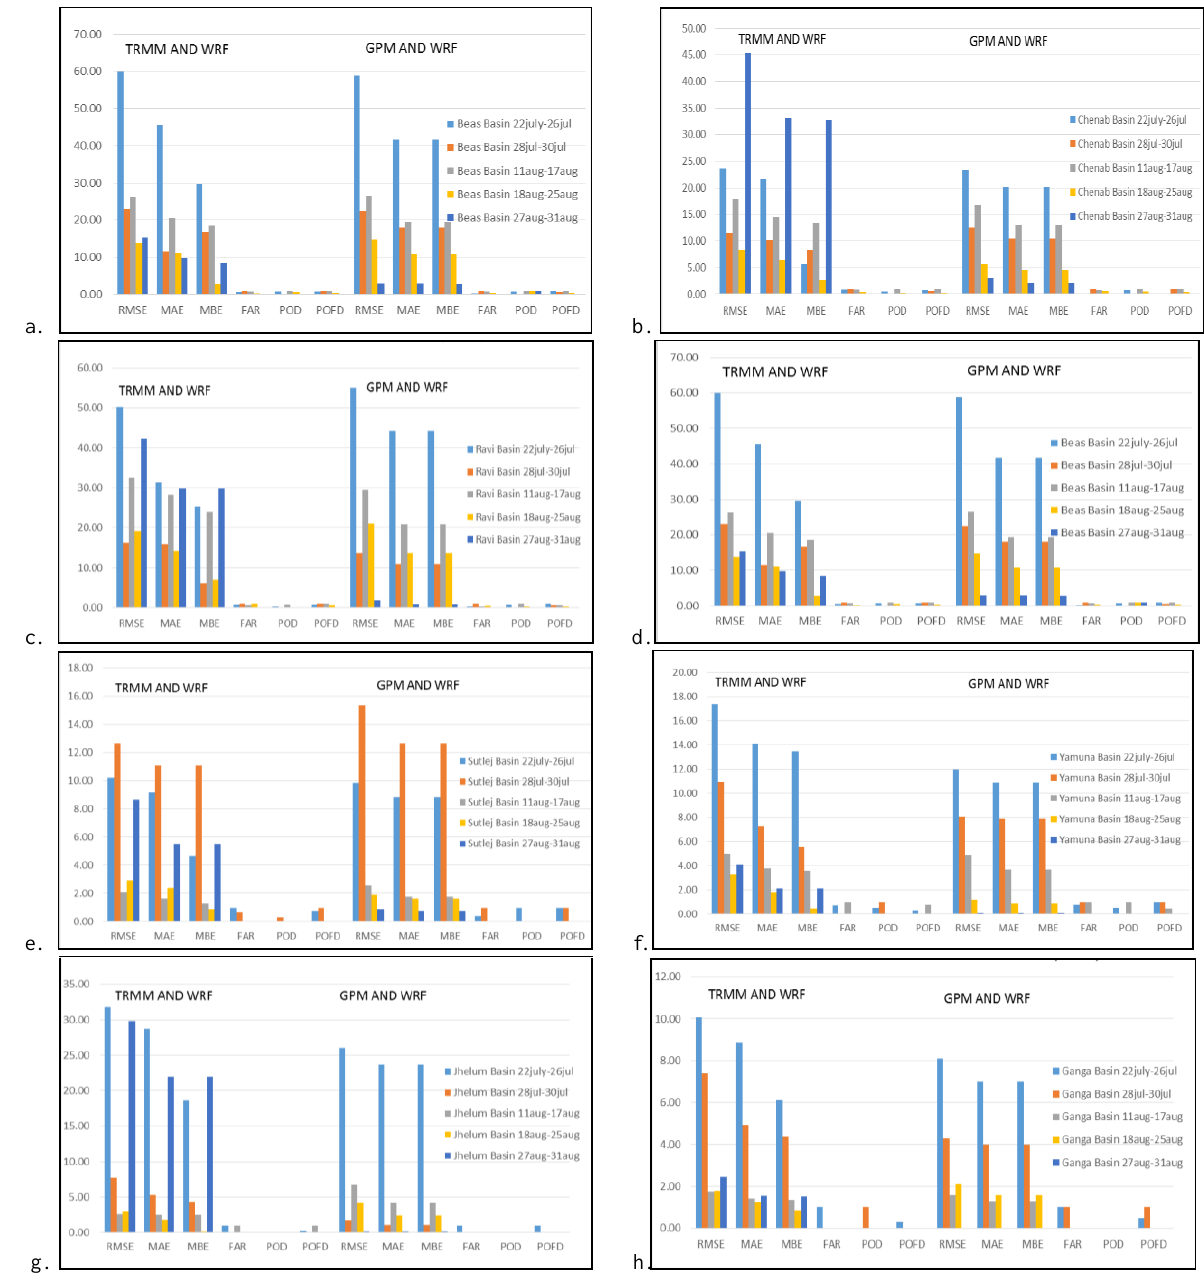
Figure 9: WRF data verification w.r.t. satellite products for (a) Indus, (b) Chenub, (c) Ravi, (d) Beas, (e) Sutlej,